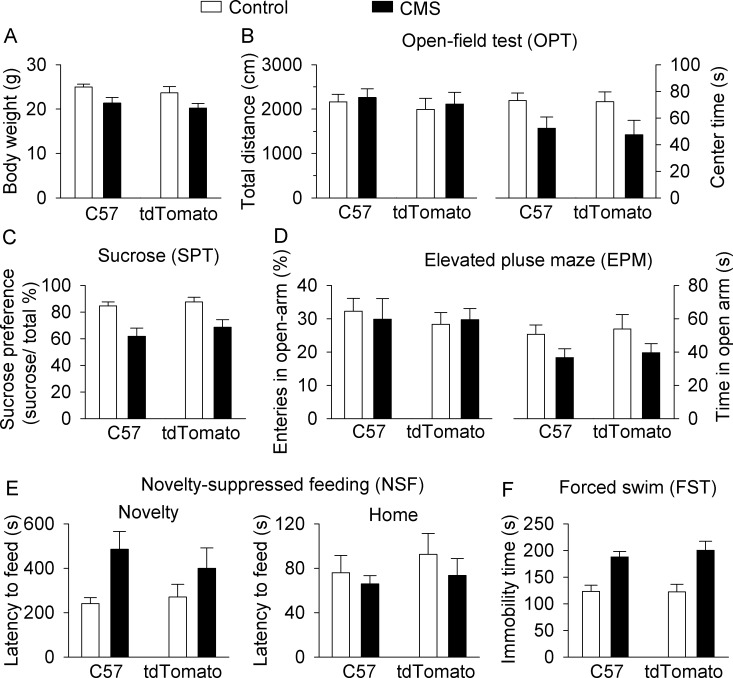
C57BL/6J and DAT-tdTomato mice do not significantly differ in body weight or behaviors at baseline or in response to CMS.Figure 1 was reanalyzed to compare C57BL/6J (C57) and DAT-tdTomato (tdTomato) reporter mice for control and CMS-induced effects on body weight (A) and behavior in OPT (B) SPT (C) EPM (D) NSF (E) and FST (F). Detailed statistical analysis is presented in Supplementary file 1. Control-C57, n = 7 mice; control-tdTomato, n = 6 mice; CMS-C57, n = 7 mice; CMS-tdTomato, n = 6 mice.